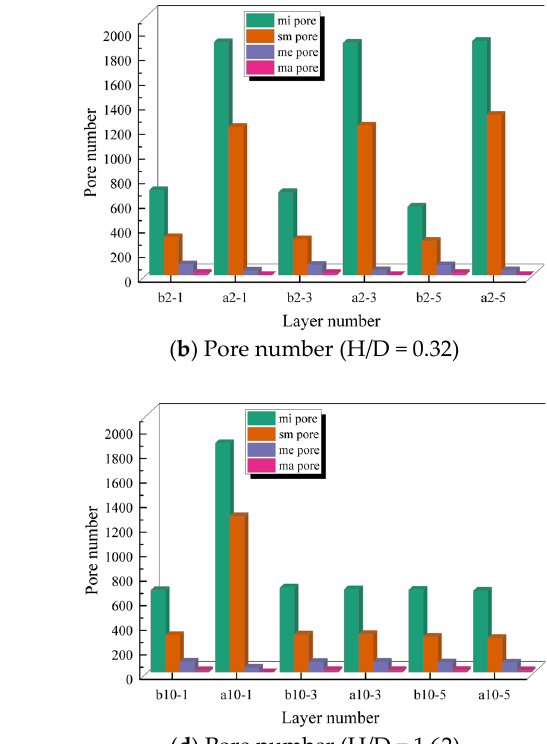
Figure 8. Variation of PAR with different H/D ratios along the sample height after compression.